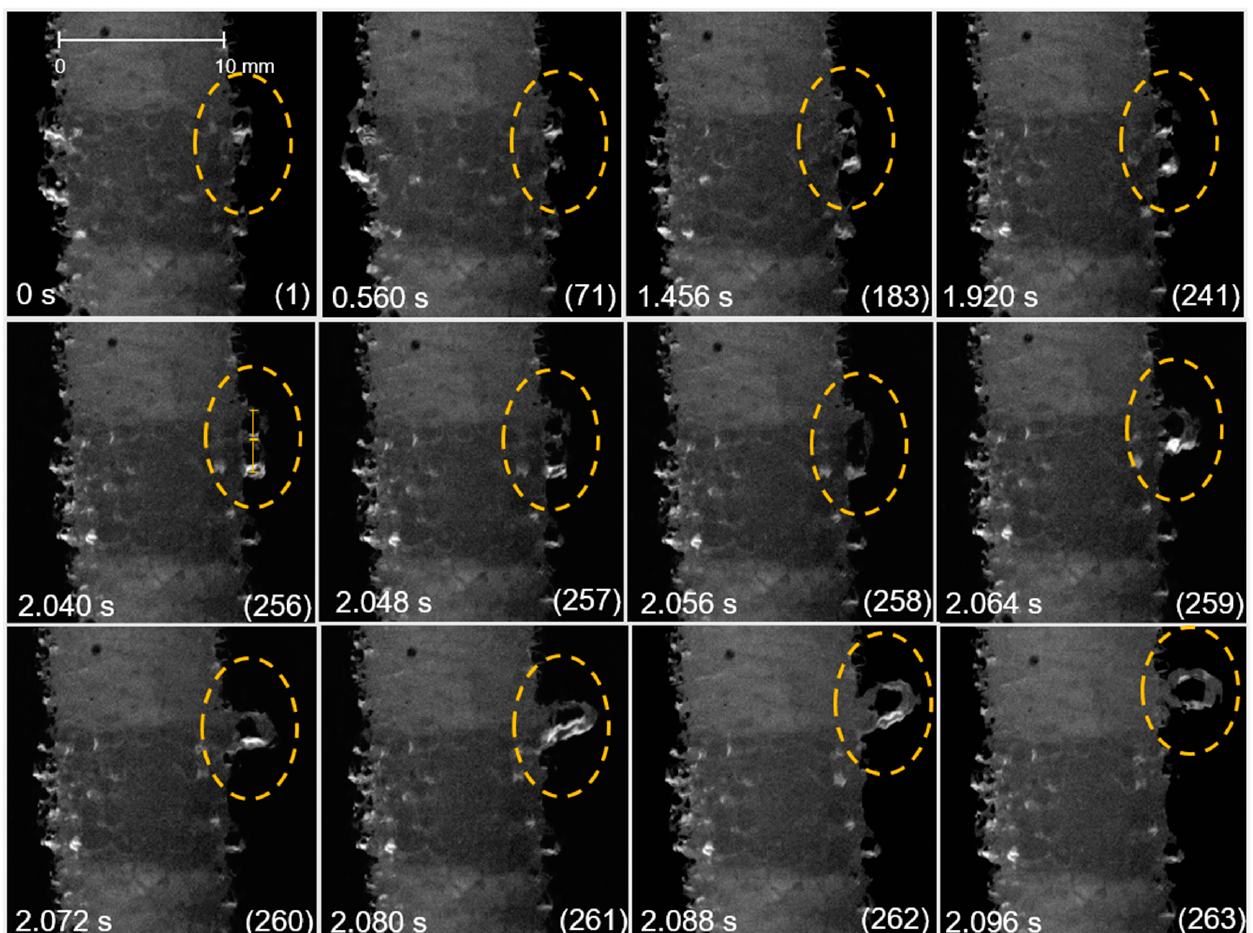
Figure 13. Process of coalescence of two bubbles (marked in yellow dashed line) into one bigger bubble and its immediate detachment from the vertical surface during electrolysis at a constant current density of 0.1 A cm − 2 . The frame rate was 125 fps. The frame number is given in the brackets. Frame (1) is defined as 0 s. A scale bar is shown in frame (1).